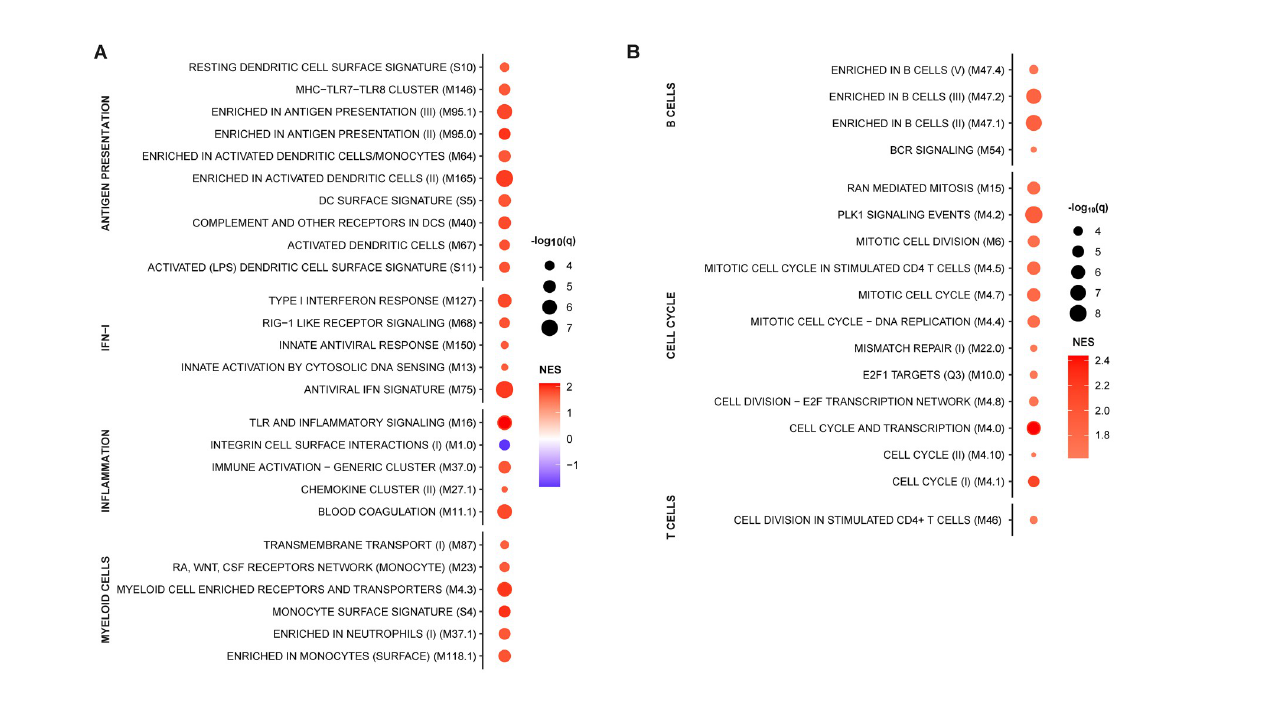
Fig 2. Whole blood transcriptome module (BTM) analysis of farm pigs compared to SPF pigs. Data points show significantly different (A) innate and (B) adaptive immune cell BTMs between farm and SPF pigs using SPF leukocytes as reference in steady state. BTM modulations were calculated as normalized enrichment scores (NES) using GSEA. Increased (red) or decreased (blue) BTMs in farm compared to SPF pigs are shown with color intensity proportional to the NES and the size of the data points proportional to the statistical q value. Data is from n = 12/group from 2 independent experiments.